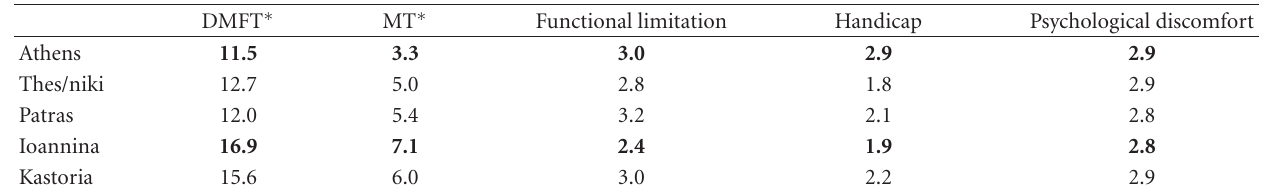
Table 5: Comparison of DMFT scores and the MT component from similar population groups to the results of 3 OHIP-14 subscales in the present study.